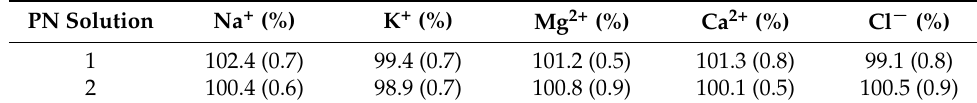
Figure 5. Response surface plots depicting the influence of MSA concentration and temperature on ( a ) resolution between Na + and K + ; ( b ) resolution between K + and Mg 2+ ; ( c ) resolution between Mg 2+ and Ca 2+ .